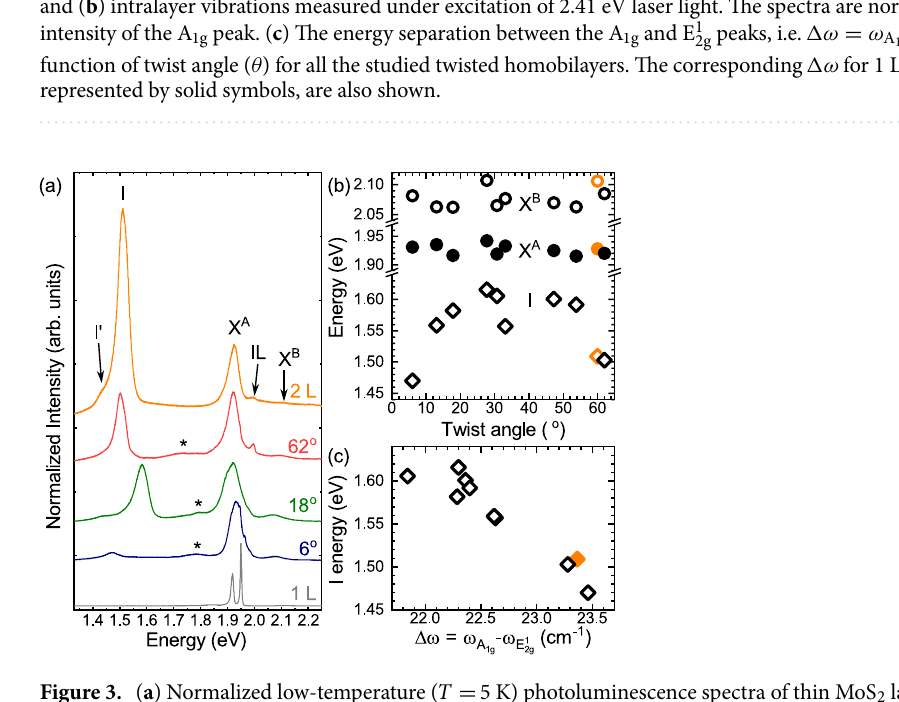
− ω E 1 2g , as a 1g